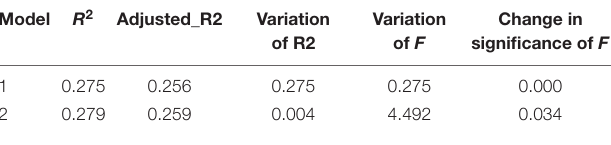
TABLE 7 | Regulatory effect test results – based on R2.